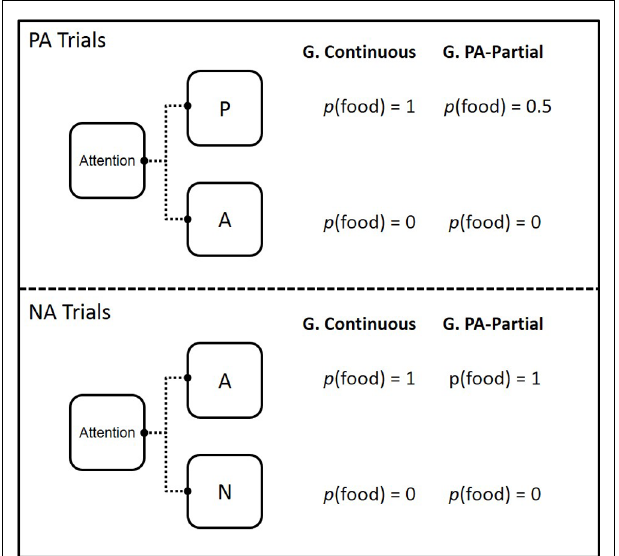
FIGURE 1 | Design of Experiments 1 and 2. The colors (red, green, and blue) associated with stimuli P, A, and N were counterbalanced across subjects. P, A, and N appeared equally often on the left and right keys; G denotes Group and p denotes probability.